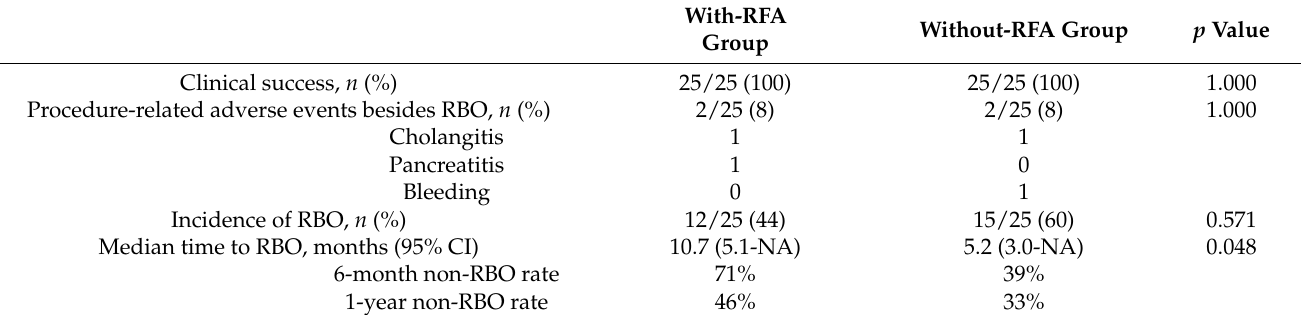
Table 2. Outcomes of stent placement with/without radiofrequency ablation.